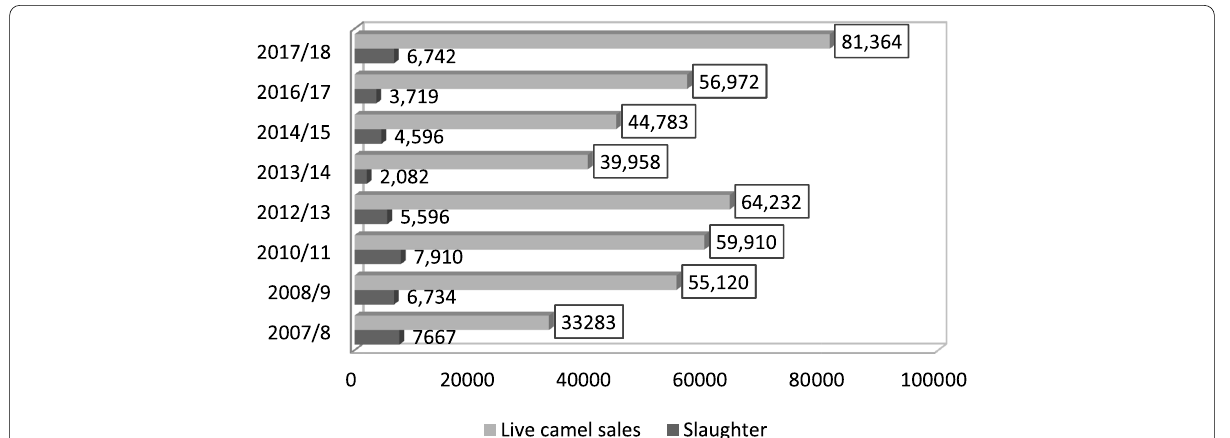
Fig. 2 Live camel sale and domestic slaughter in Ethiopia. Source: author computation the Central Statistical Agency